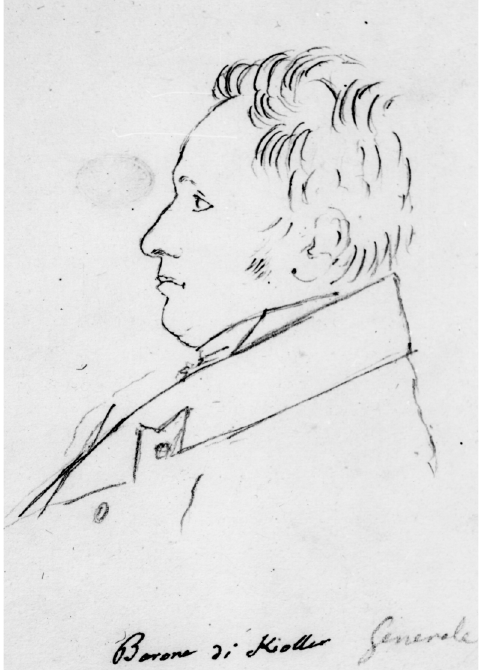
Fig. 2. Portrait of Ferdinando Visconti, taken by Gio- vambattista Amici with his «camera lucida» in 1817 during his stay in Naples (Biblioteca Estense di Mode- na, Fondo Amici, donazione eredi).